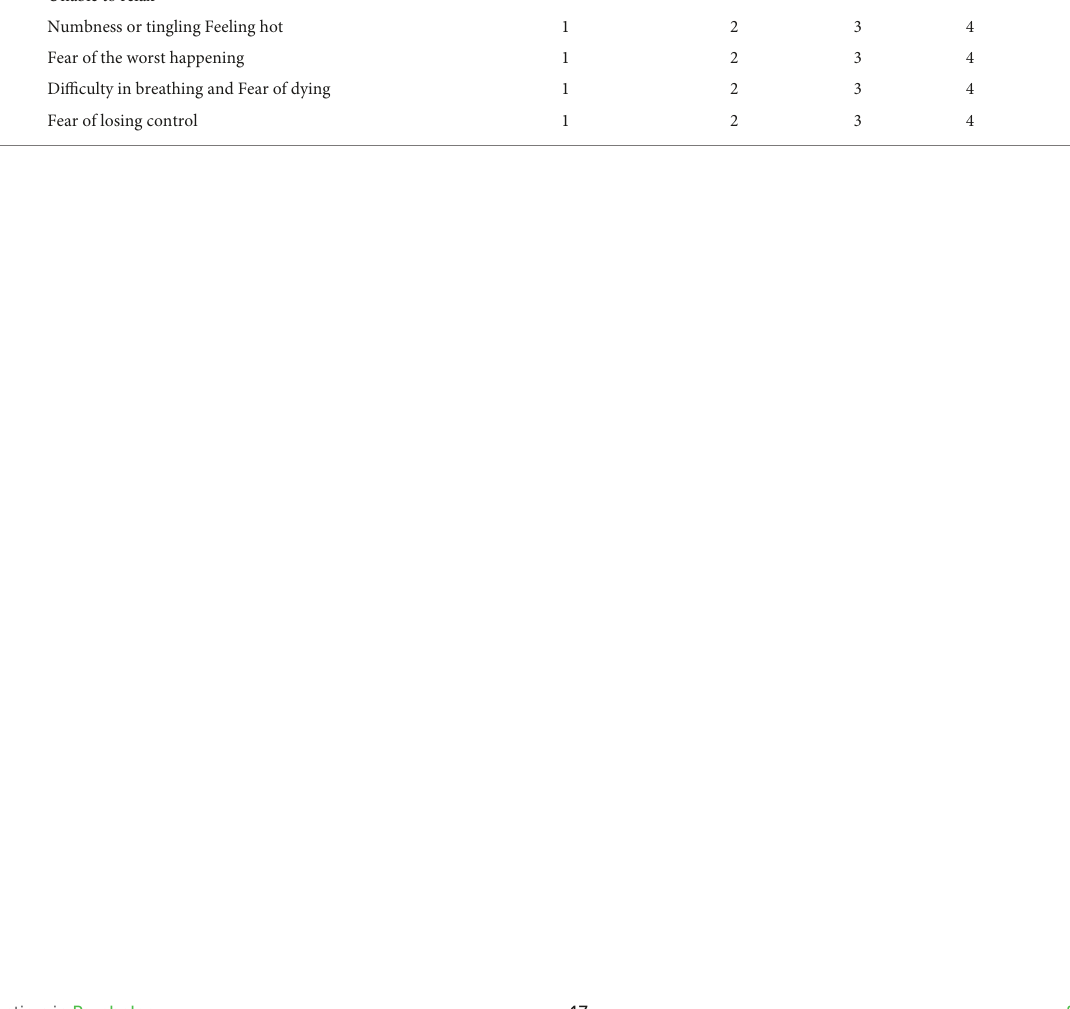
S# Psychological distress I see myself as someone who often feels... Wobbliness in legs Unable to relax